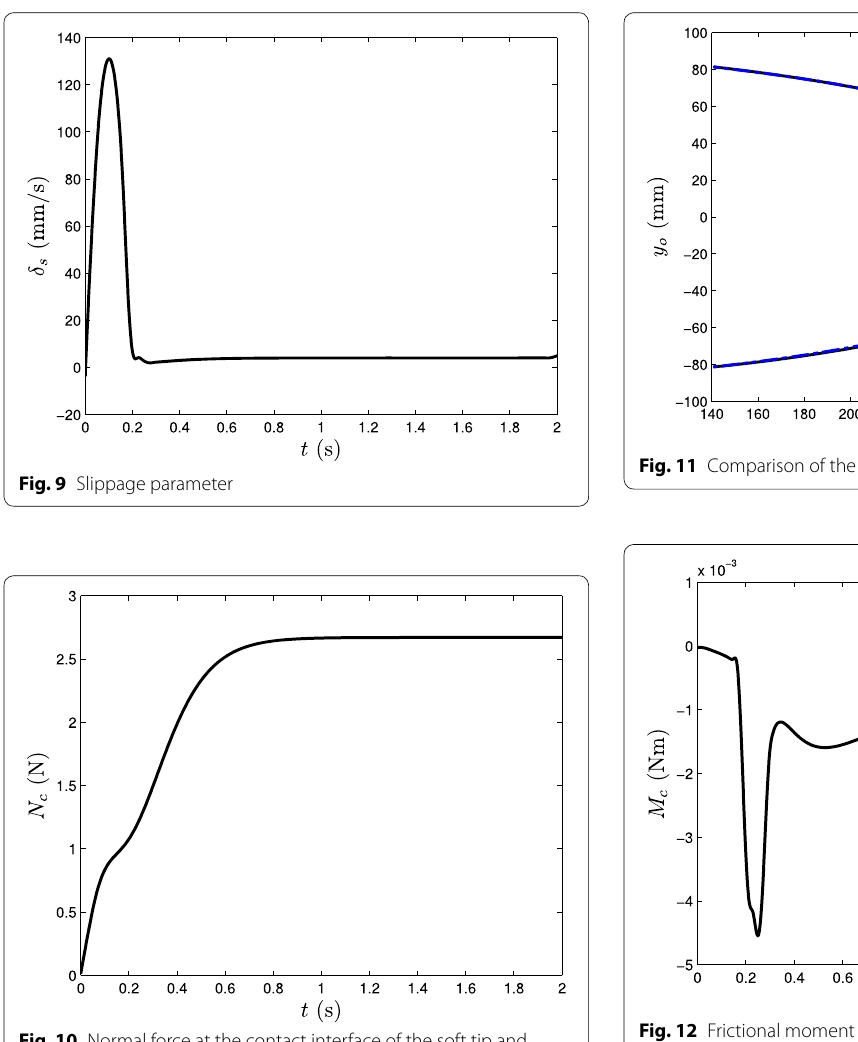
Fig. 10 Normal force at the contact interface of the soft tip and object